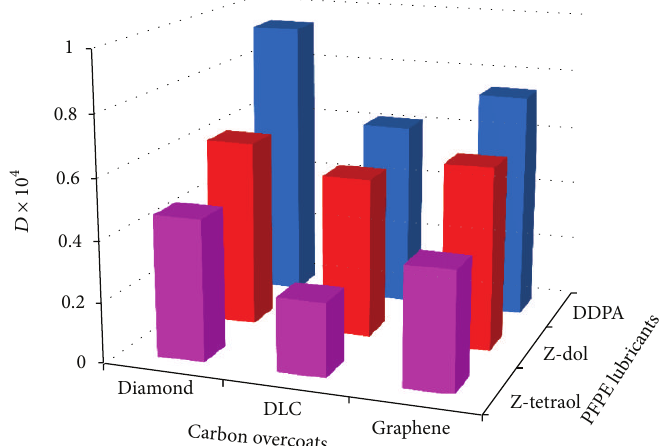
Figure 28: Perpendicular component of self-diffusion coefficients ( 𝐷 ⊥ [𝜎 2 /𝜏] ) for each component of the material matrix.